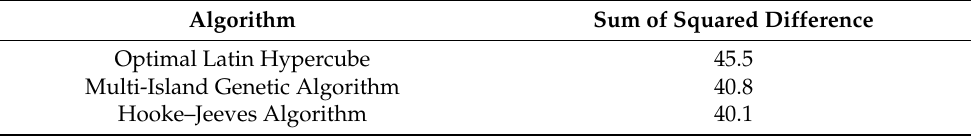
Table 3. Comparison of the SSD based on the optimization algorithm.